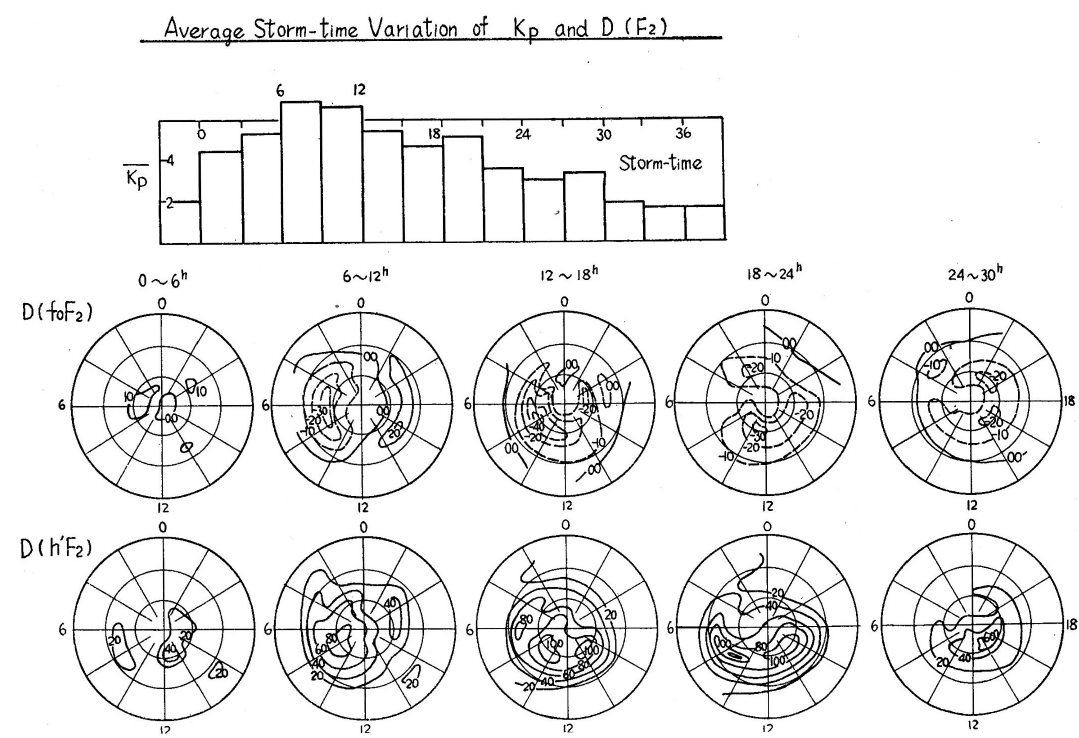
Figure 5. Ionospheric disturbance in the F2 layer obtained by averaging ten storms in 1950–1951 every six hours after the beginning. Top: Kp index, middle: percentage deviations of fo F2, and bottom: deviations of h 0 F2 in km (Obayashi,